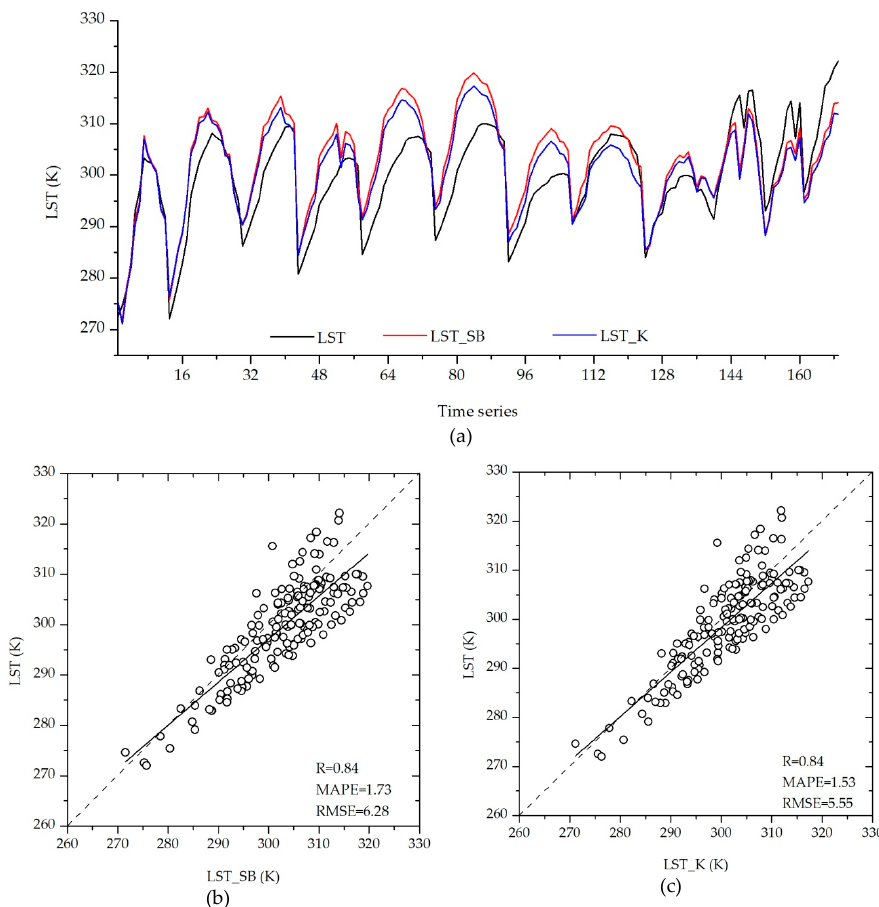
Figure 7 . The c omparison of LST retrieved by different split-window algorithms and measured Figure 7. The comparison of LST retrieved by di ff erent split-window algorithms and measured values, values, (a) is the time series, (b) is the LST retrieved by B&L algorithm, (c) is the LST retrieved by ( a ) is the time series, ( b ) is the LST retrieved by B&L algorithm, ( c ) is the LST retrieved by Kerr Kerr algorithm.